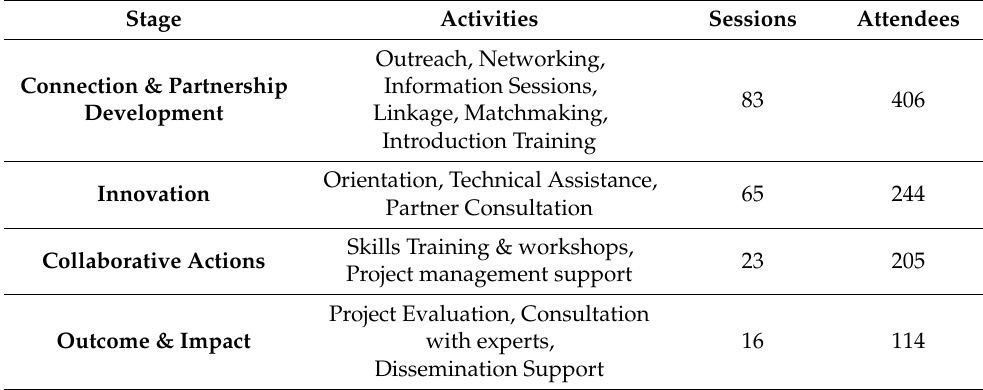
Table 3. Morgan CARES Support Activities and Services